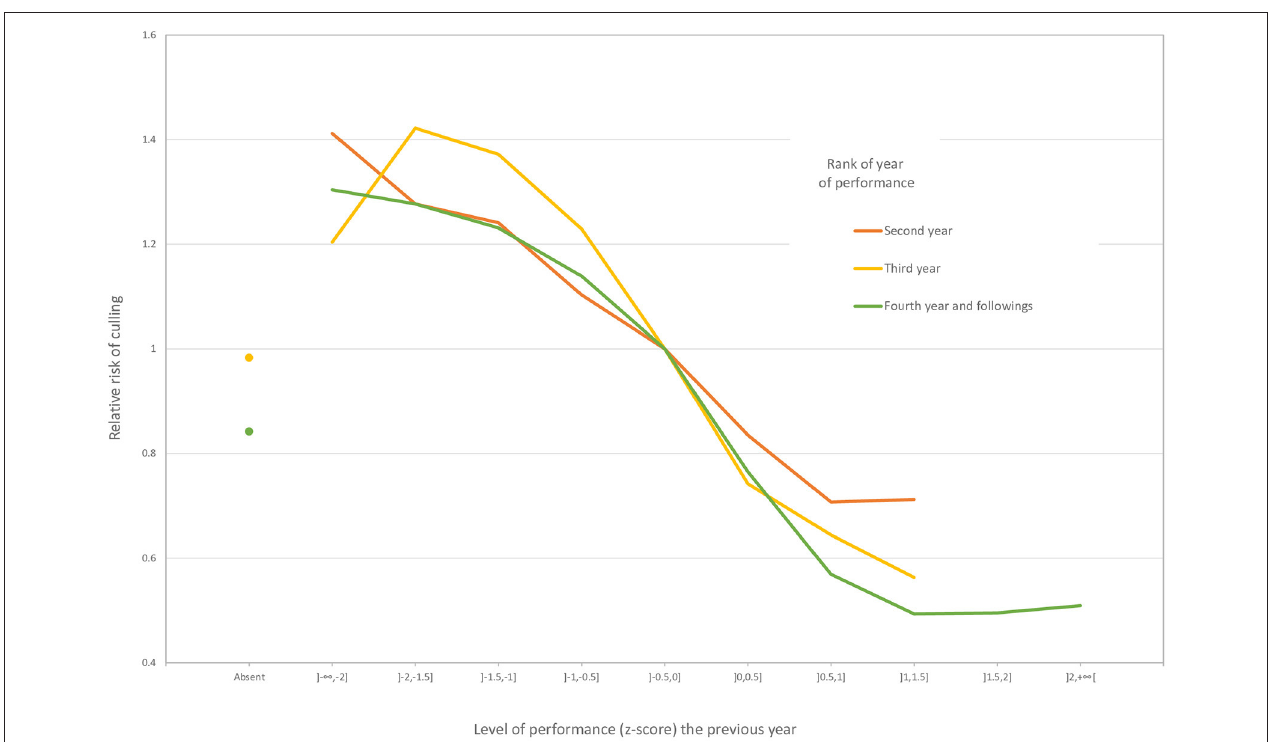
FIGURE 1 | Effect of the level of performance on the risk of culling in jumping competition for geldings.